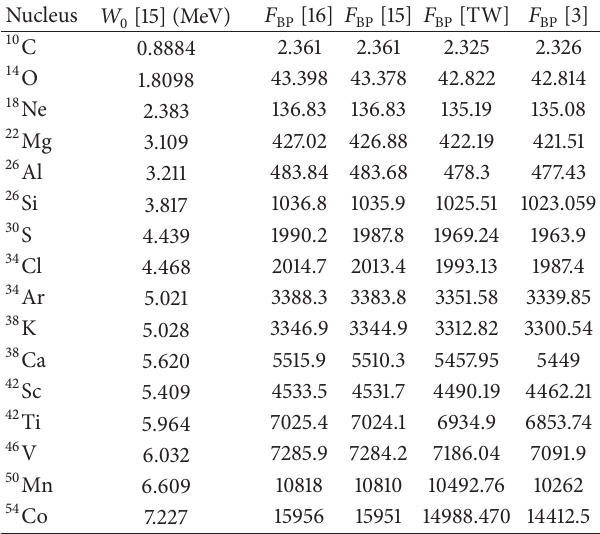
Table 1: Calculated phase space of 𝛽 + -decay (BP) compared with previous calculations. The value of maximum 𝛽 -decay energy is taken from [15] for pure Fermi transitions. The last two columns show our calculated results.